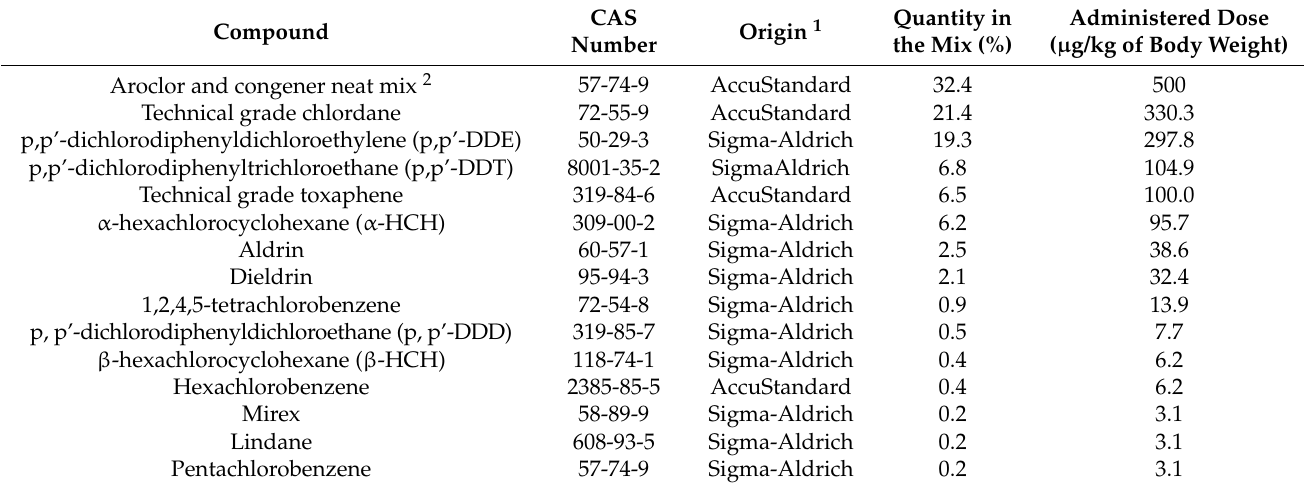
Table 1. Composition of the persistent organic pollutant (POP) mixture